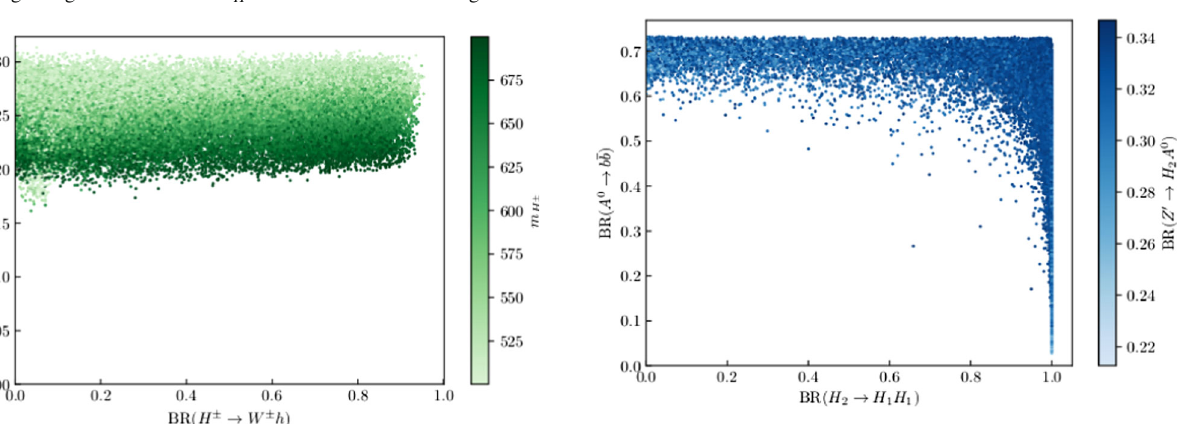
Fig. 3 Branching ratios for Z (cid:2) → H + H − versus H ± → W ± h result- ing from the parameter space scan in scenario 1. The colour grading is related to the m H ± value as shown on the right